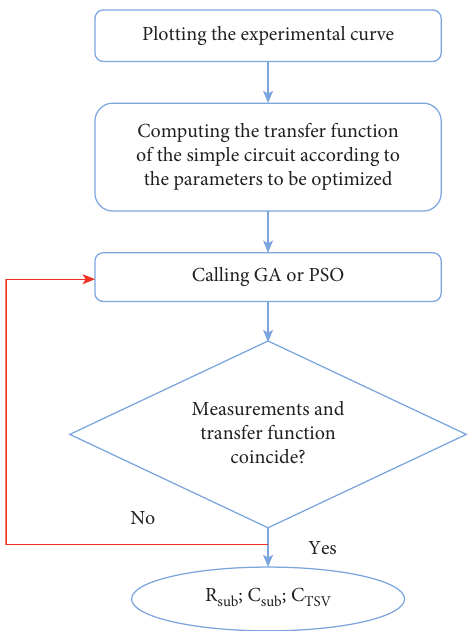
Figure 11: Identification